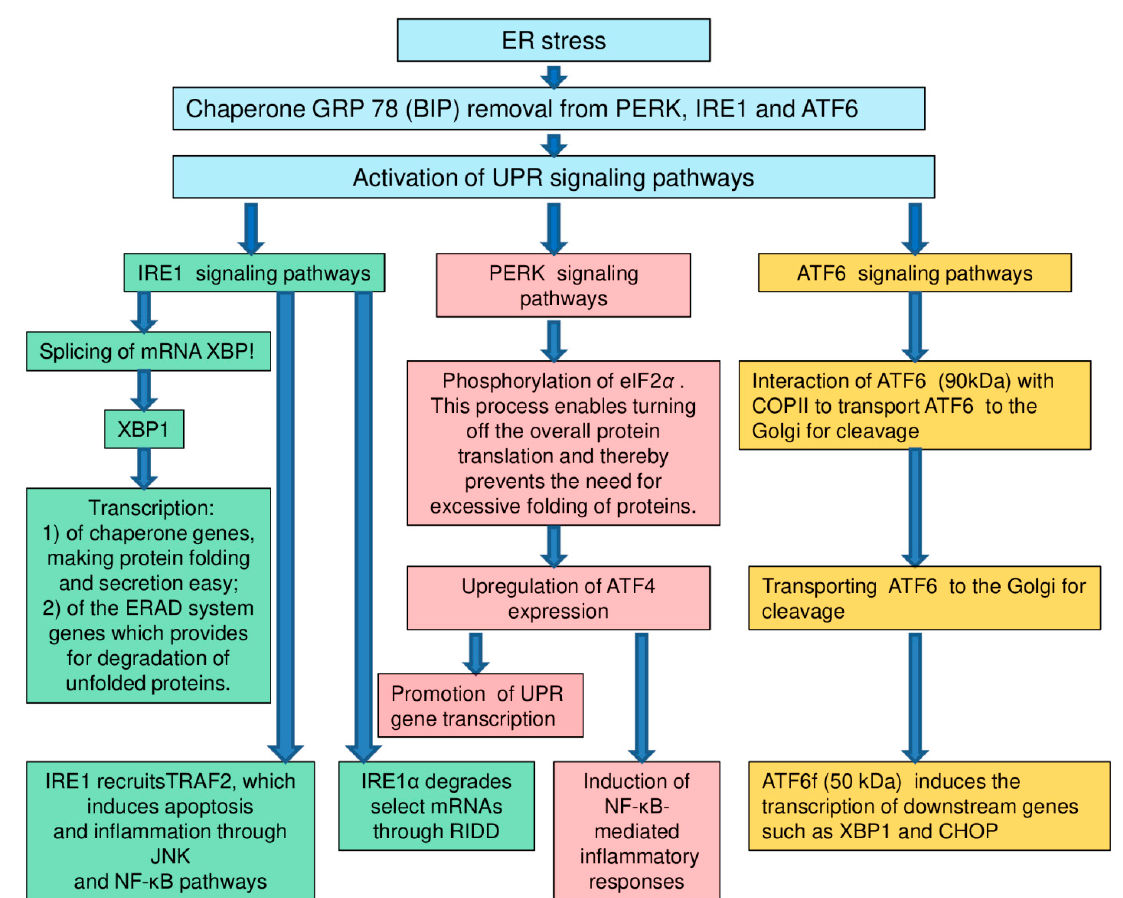
Figure 1. Signaling pathways [128]. Remark: UPR: unfolded protein response; ER: endoplasmic reticulum; IRE1: inositol-requiring enzyme 1; PERK: protein kinase RNA- (PKR-) like kinase; ATF6: activating transcription factor 6; XBP1: X-box-binding protein-1; TRAF2: tumour necrosis factor receptor- (TNFR-) associated factor-2; JNK: Jun-N-terminal kinase; NF- κ B: nuclear factor κ B; RIDD: regulated IRE1-dependent decay; eIF2 α : eukaryotic translation initiation factor 2 α ; ATF4: activating transcription factor 4; COPII: coat protein II; CHOP: CCAAT/enhancer-binding protein-homologous protein.